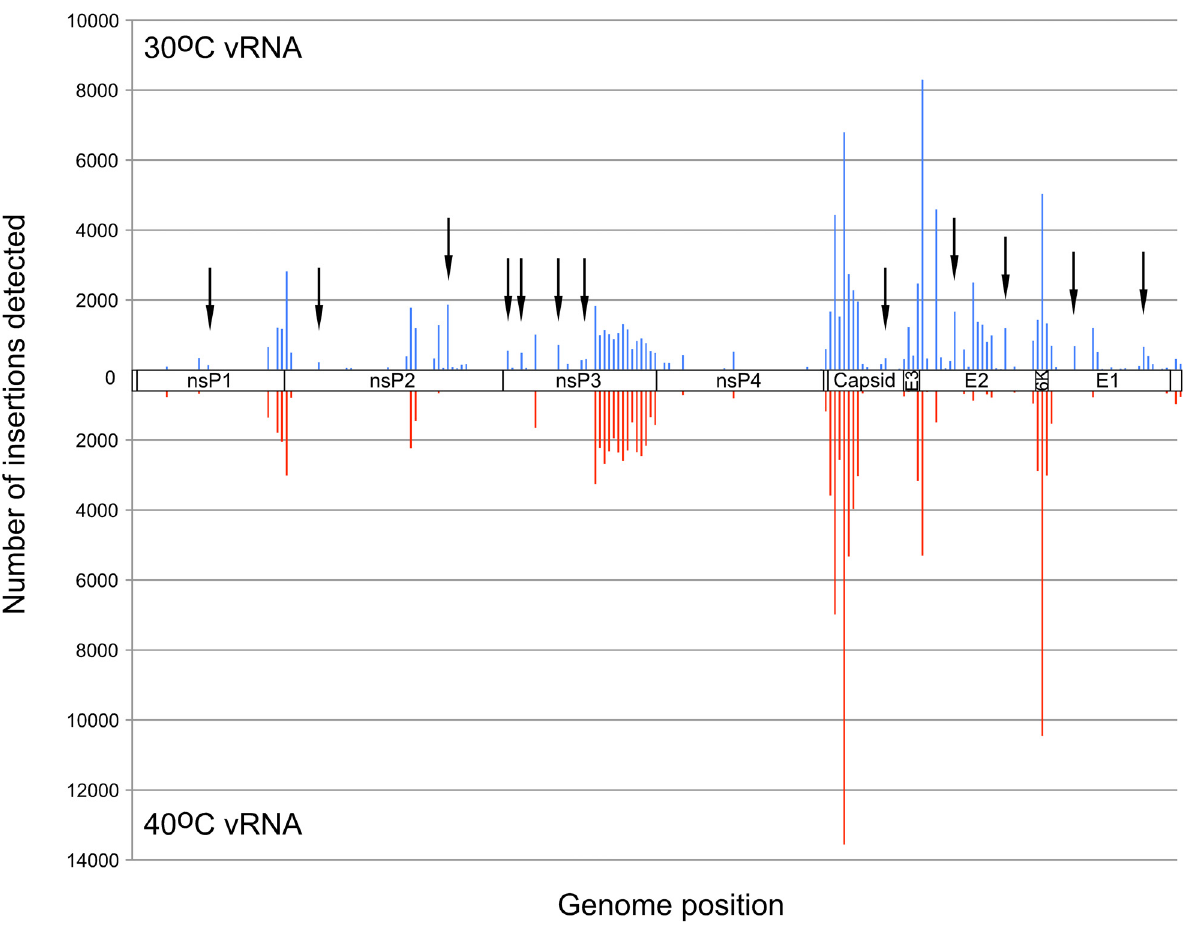
Figure 4. Frequency of insertion sites found in vRNAs of virus propagated at 30 u C or 40 u C. Transposon insertion frequencies were calculated for vRNAs isolated from 30 u C and 40 u C. Insertion frequencies for 50 nt bins are shown. 30 u C frequencies are shown on top in blue, and 40 u C frequencies are shown in red. Arrowheads indicate some of the regions in which more insertions were detected at 30 u C than at 40 u C.